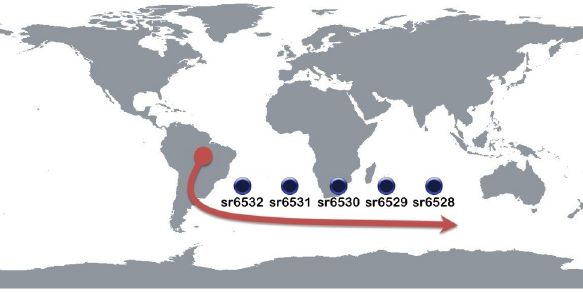
Fig. 4. Example of sequential ACE-FTS measurements sampling a continuous plume outflow originating from the tropical forests in Amazonia on 29 October